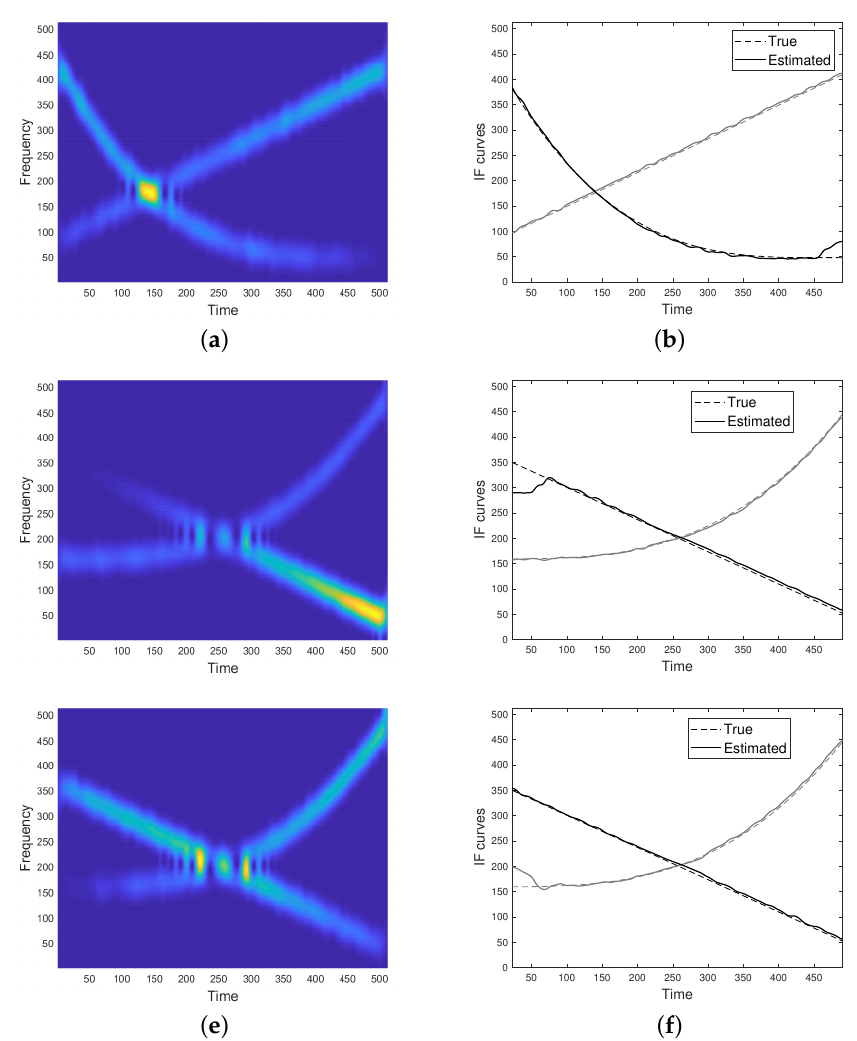
Figure 11. ( a ) Spectrogram of the signal in Equation (27), embedded in AWG noise at SNR = 16dB and ( b ) IF curves provided by the proposed method. ( c ) Spectrogram of the signal in Equation (29), embedded in AWG noise at SNR = 20dB and ( d ) IF curves provided by the proposed method. ( e ) Spectrogram of the signal in Equation (30), embedded in AWG noise at SNR = 18dB and ( f ) IF curves provided by the proposed